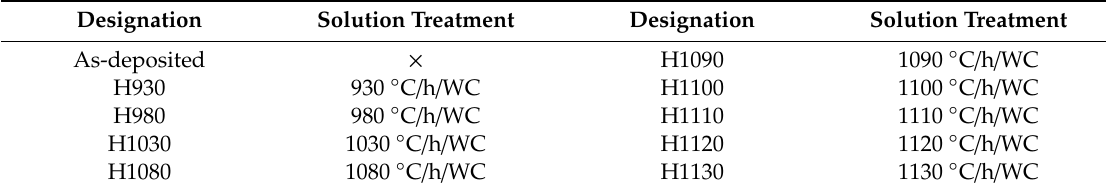
Table 2. Solution heat treatment process